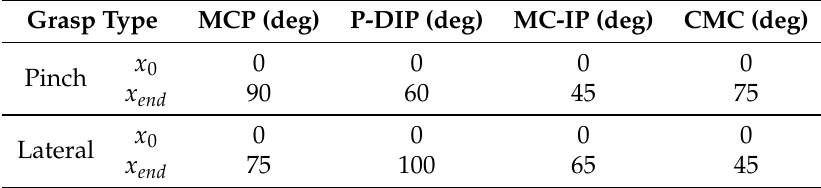
Table 1. Reference values for hand exoskeleton (HX) actuator